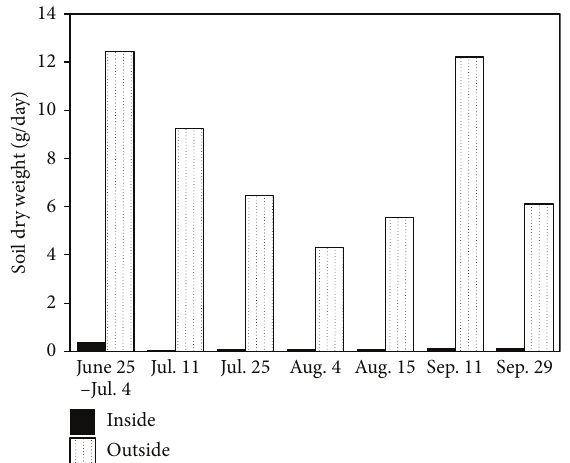
Figure 7: Weight of soil captured in box traps inside and outside the deer exclosure in Okutama, western Tokyo, Japan, from late June to mid-September,